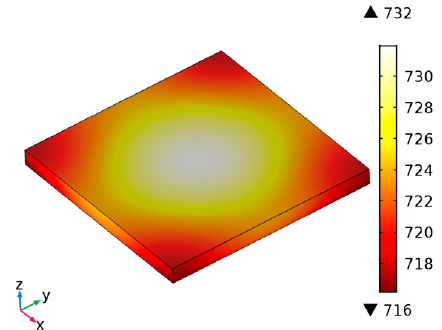
Figure 2. The temperature distribution of an SiC sample placed on a steel sheet irradiated with 50 W laser power for 120 s.